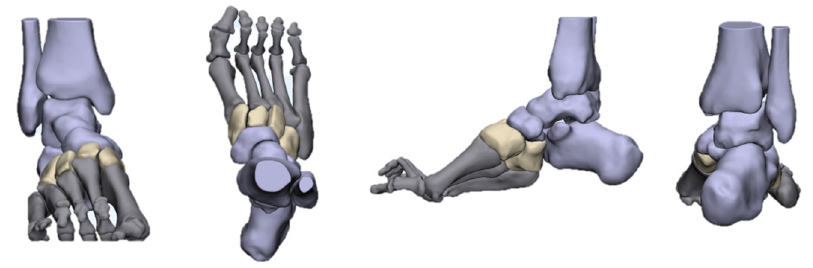
Figure 2. Three-dimensional view of cavus foot.